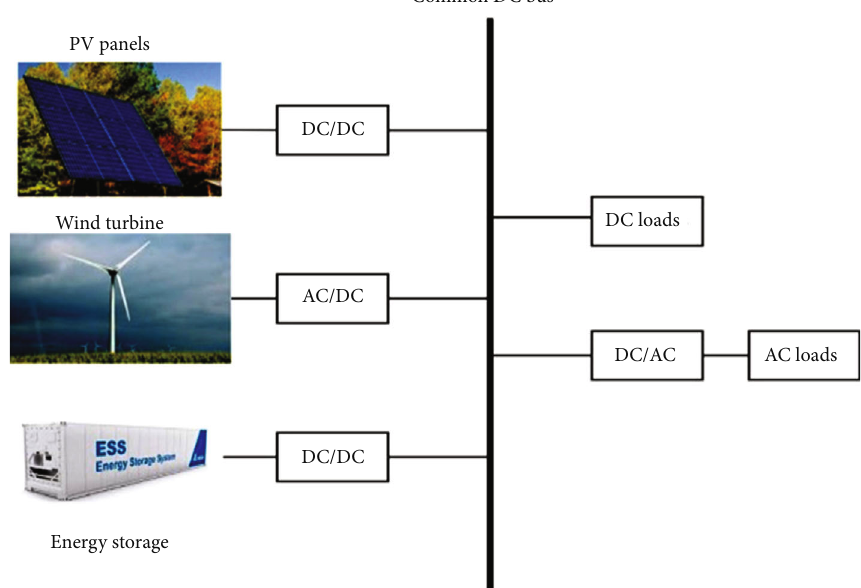
Figure 1: Overview of DC microgrid.